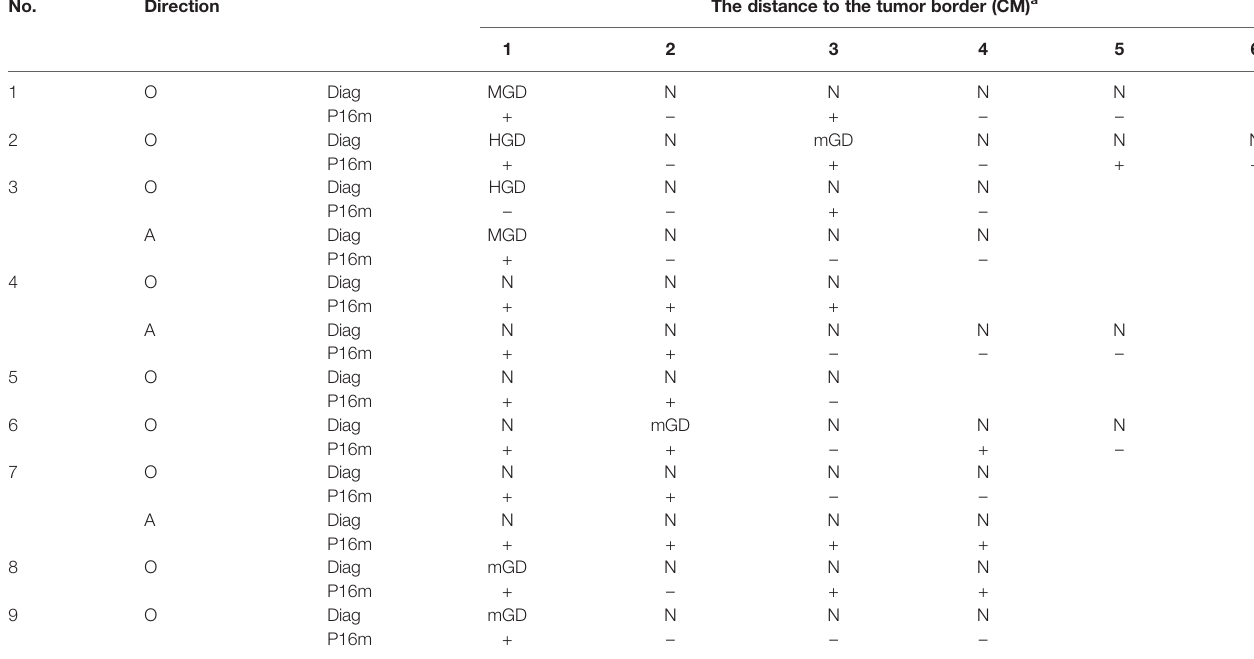
TABLE 5 | Pathological diagnosis and p16 methylation of SM biopsies. No.